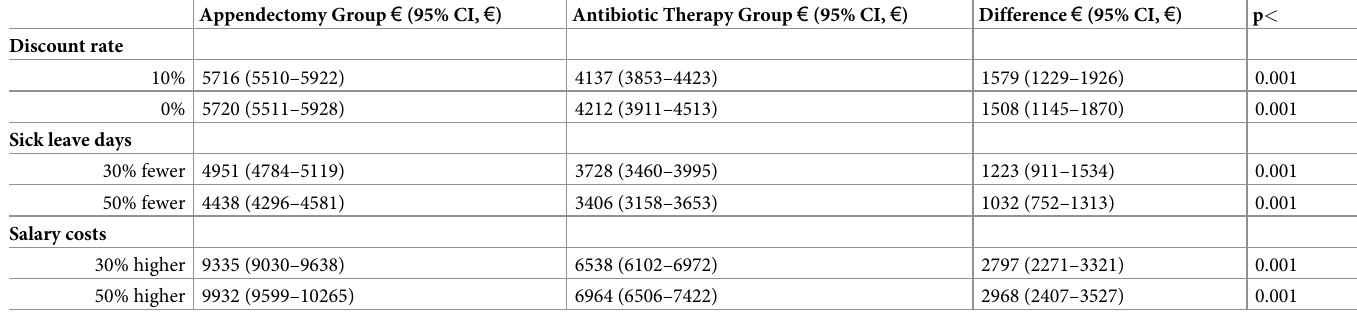
Table 2. Sensitivity analyses of mean overall costs of appendectomy and antibiotic therapy group patients with uncomplicated acute appendicitis in Euros per patient at five-year follow-up. Appendectomy Group € (95% CI, €